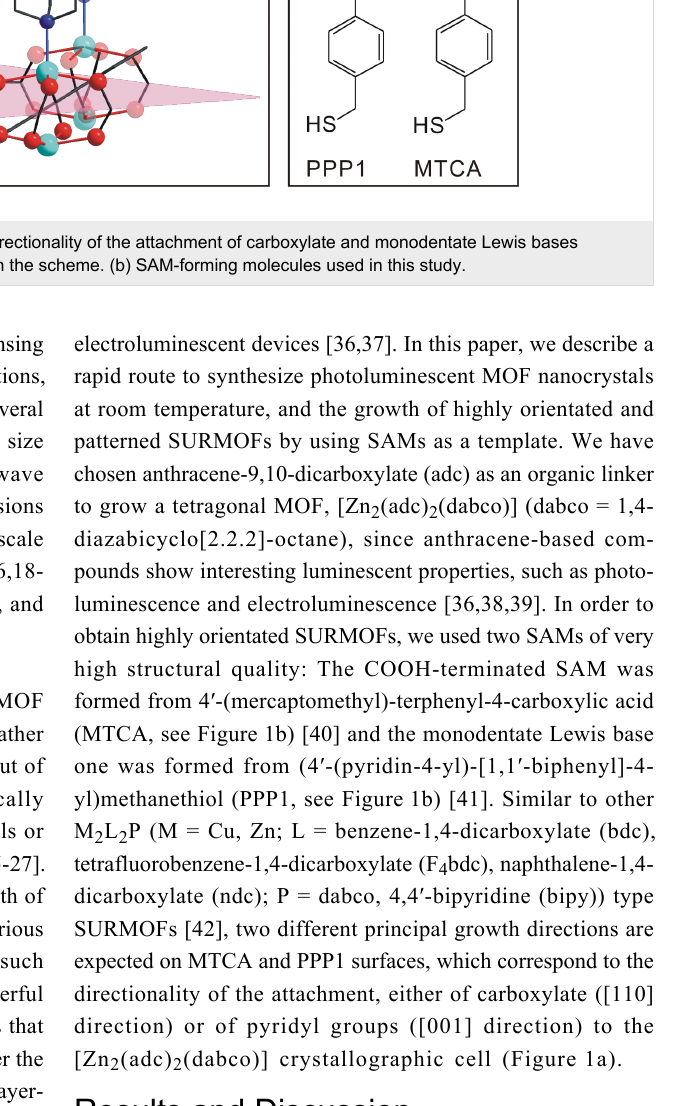
Thus, nanoscale MOFs have attracted great attention for